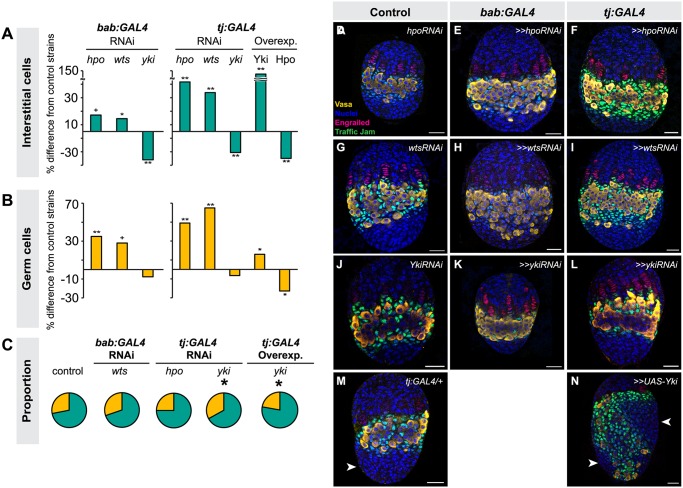
Altering Hippo pathway activity in somatic cells changes IC and GC number.Changes in (A) IC or (B) GC number in ovaries expressing hpo, wts or yki RNAi, or overexpressing hpo or yki under the bab:GAL4 or tj:GAL4 drivers. Bar graphs are as explained in Fig. 2 legend. ** p<0.01, * p<0.05, + p = 0.05 against the UAS parental line and p<0.05 against the GAL4 parental line. n = 10 for each genotype. Numerical values can be found in S3 Table. (C) Pie charts of proportions of ICs (green) and GCs (yellow) in ovaries under indicated selected experimental conditions. * p<0.05. Numerical values can be found in S6 Table; pie charts for all experimental conditions shown in S7 Fig. (D–N) LP stage larval ovaries representative of control and experimental samples used to obtain cell type counts. Scale bar = 10 μm.